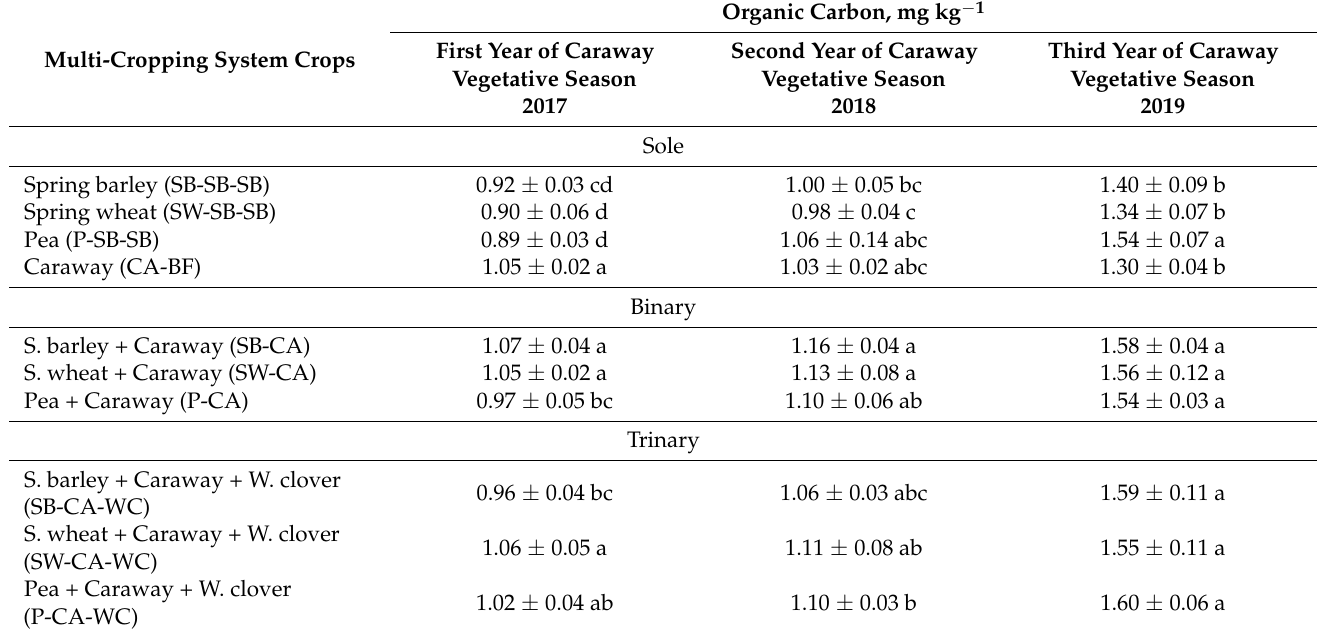
Table 2. Organic carbon content in the soil of sole, binary, and trinary crops in 2017–2019.